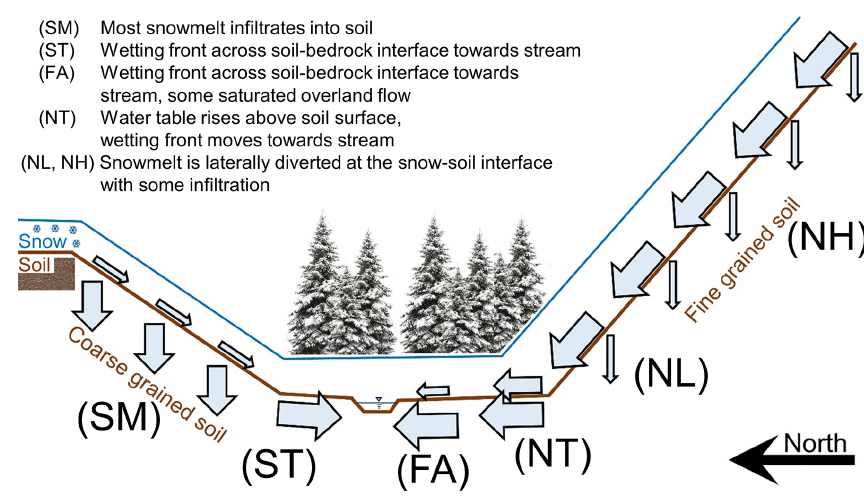
Figure 7. Conceptual model of flow paths that develop during early spring snowmelt at the south aspect hillslope (SM), toe of south aspect slope (ST), flat aspect (FA), toe of north aspect slope (NT), low on the north aspect hillslope (NL), and high on the north aspect hillslope